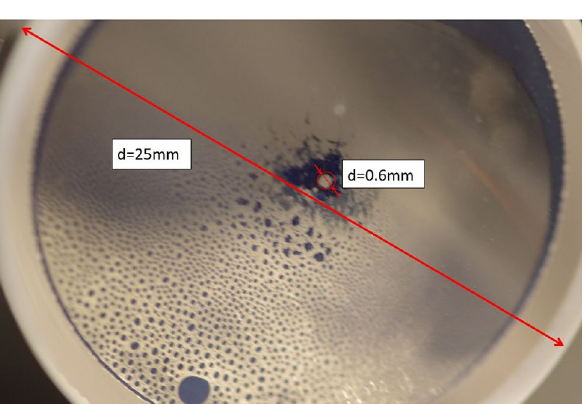
Figure 4. Exit window of the Rubidium cell after first cleaning shot. The black residue has disappeared around the focus point in a nearly regular circular area of 0.6 mm